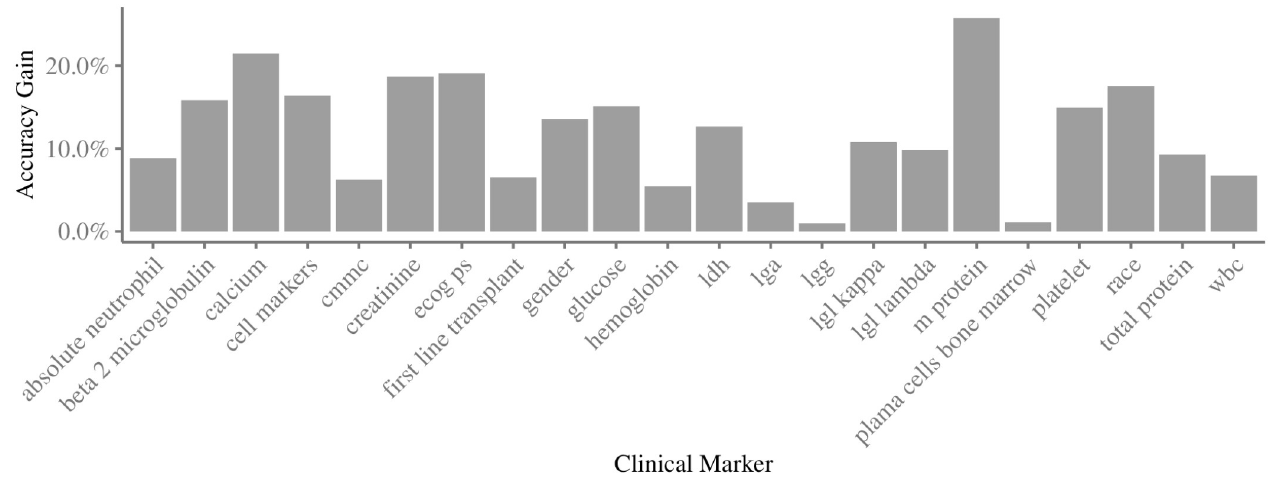
Fig 3. Improvements of TS prediction accuracy reached by gene expression levels combined to clinical markers. These results were obtained from two independent 10-fold CV experiments. First experiment uses a single clinical marker to estimate TS, and the second experiment combines that clinical marker with a set of selected